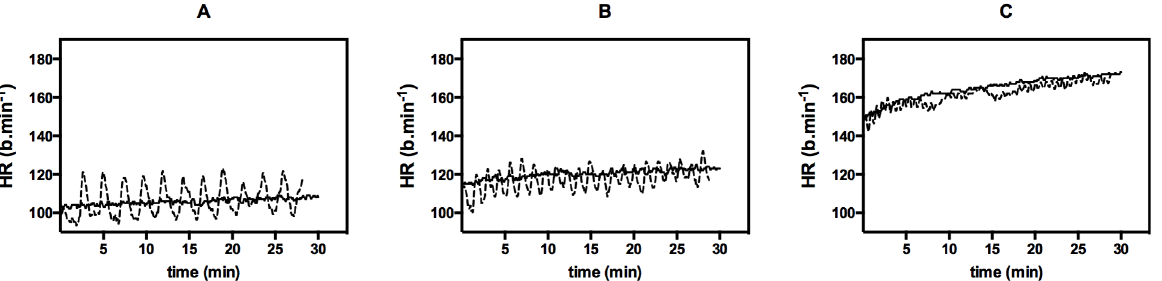
Fig 9. Comparison of heart rate (HR) response during high-intensity interval exercise (dotted line) vs. continuous exercise (full line) for mean exercise intensities A, B, and C. Values are given as mean.